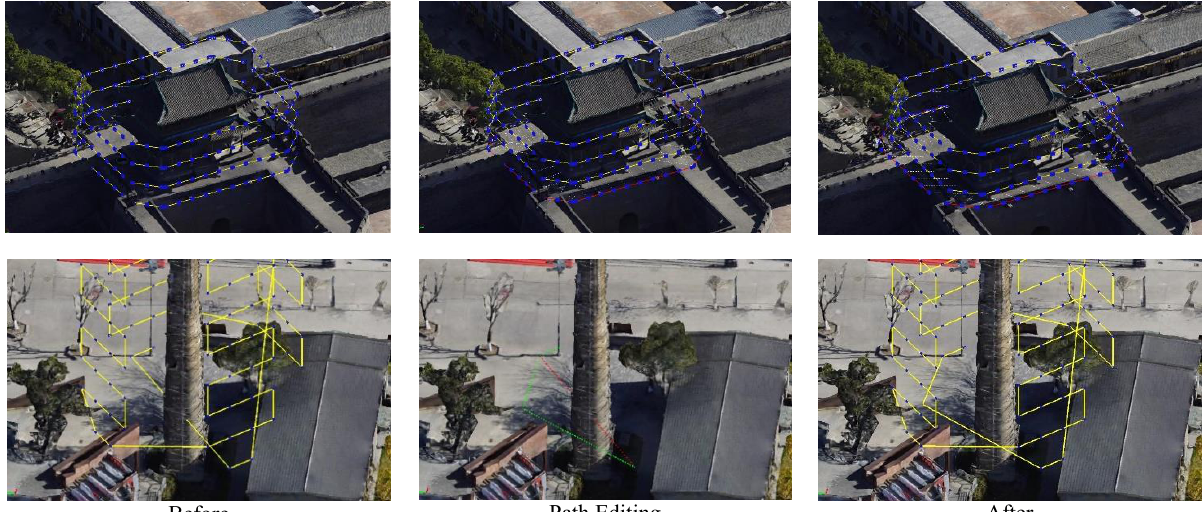
Figure 6 . Path editing methods. The first row shows the method of lifting the overall strip geometry whereas the second row shows the method of modifying the position of local